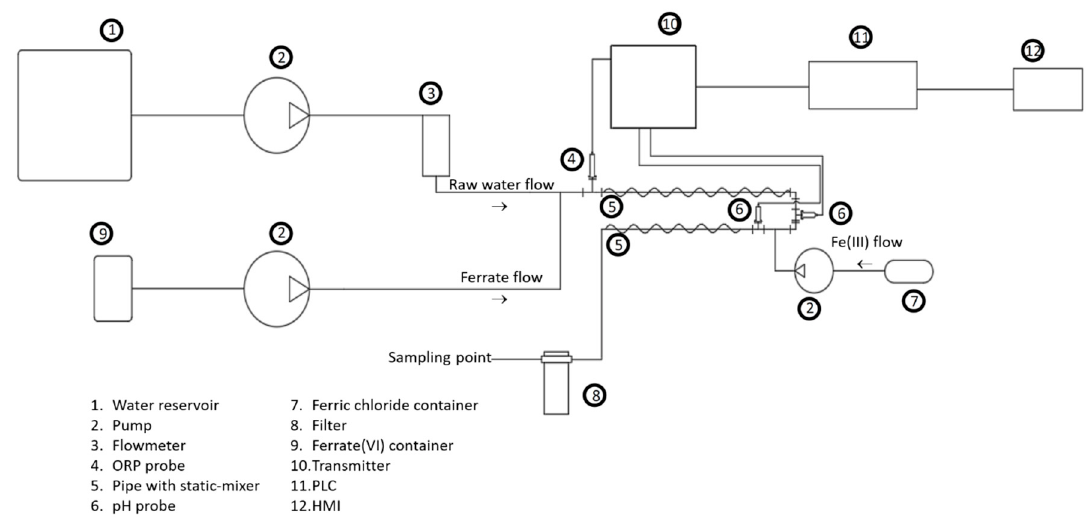
Figure 1. Water treatment plant prototype.